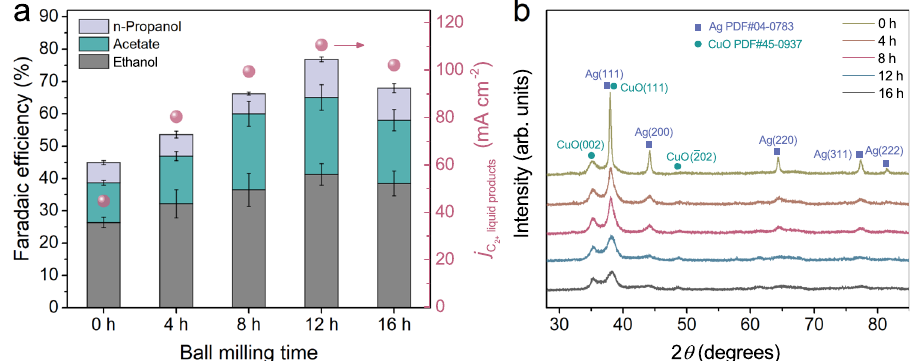
Fig. 5 | Ball milling time-dependent CORR performance and XRD patterns. a Faradaic ef fi ciency of multi-carbon liquid products. The red circles show the corre- sponding partial current densities of C 2+ liquid products. b XRD patterns of as-synthesized catalyst powder before